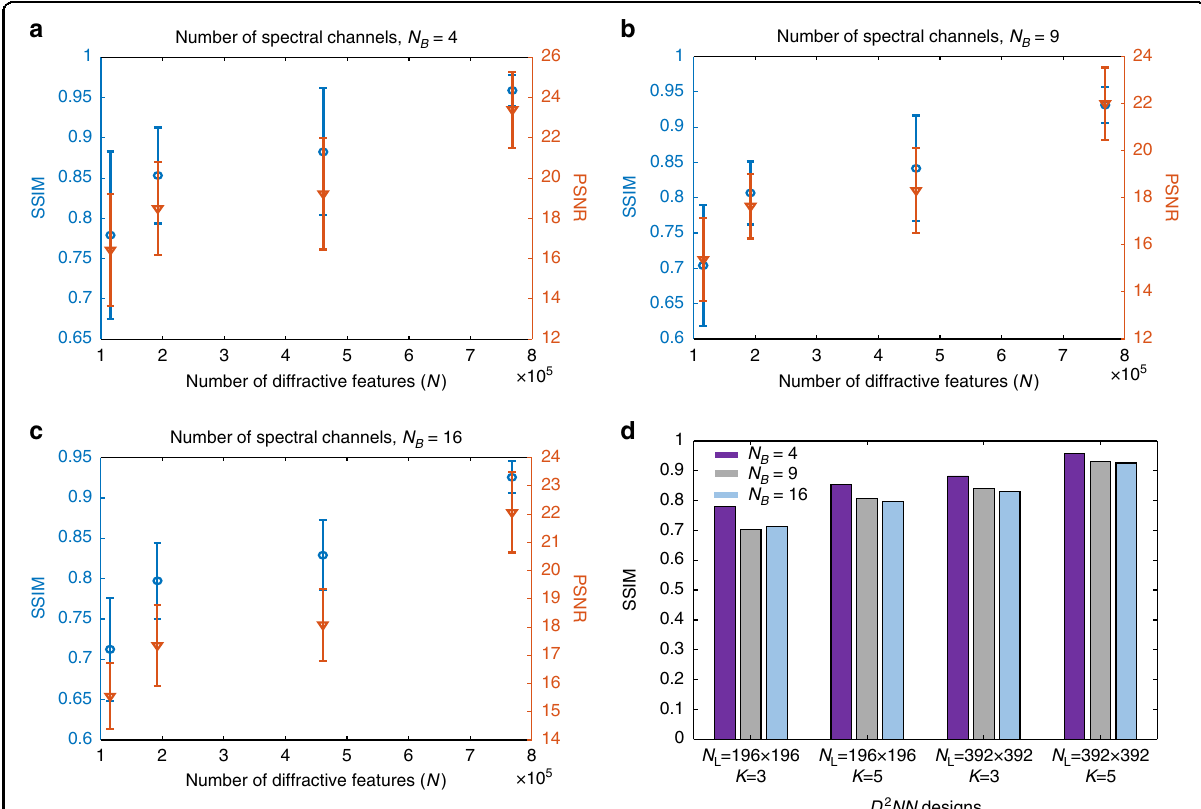
Fig. 8 The impact of the number of diffractive features ( N ) and the targeted spectral bands ( N B ) on the quality of the multispectral imaging using a diffractive optical network. Mean SSIM and PNSR values as a function of N are reported for a N B ¼ 4, b N B ¼ 9, c N B ¼ 16 spectral channels, forming a spatially repeating virtual spectral fi lter array. d The impact of N B on the SSIM of the output multispectral images for different diffractive network architectures. K refers to the number of successive diffractive layers jointly trained for multispectral imaging, and N L refers to the number of trainable diffractive features per diffractive